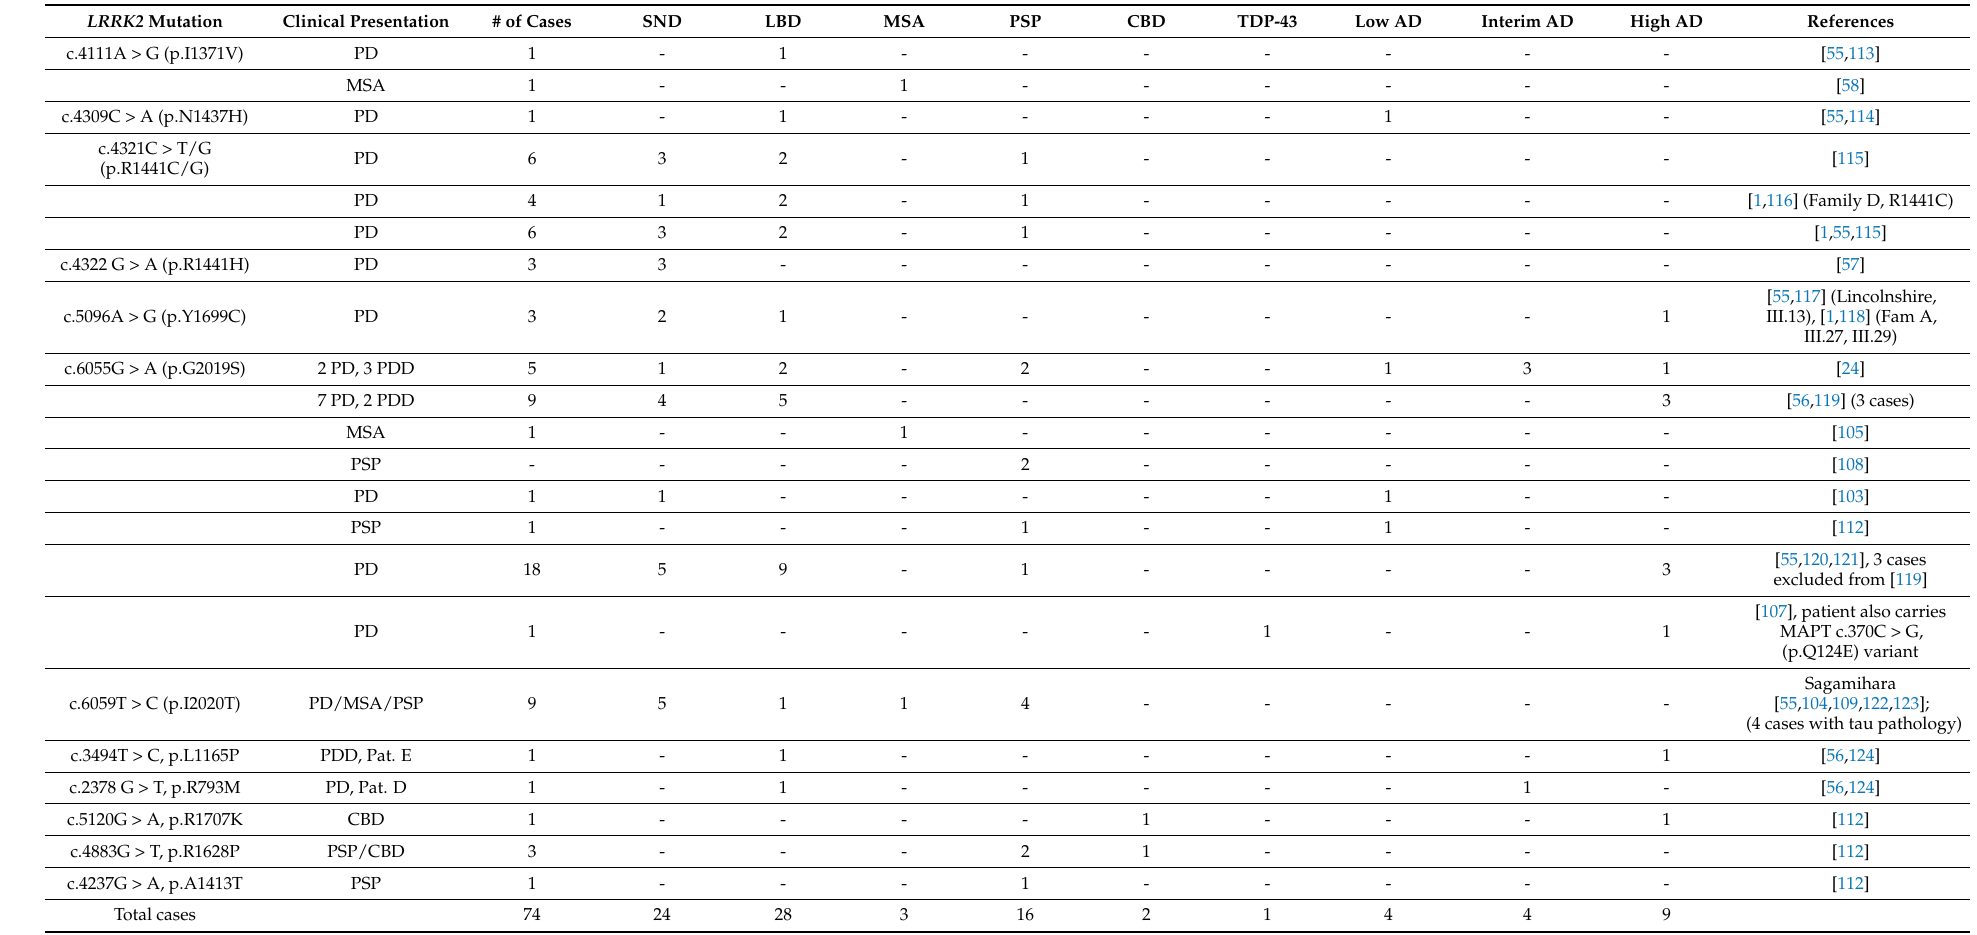
Table 2. LRRK2 cases with a neuropathological